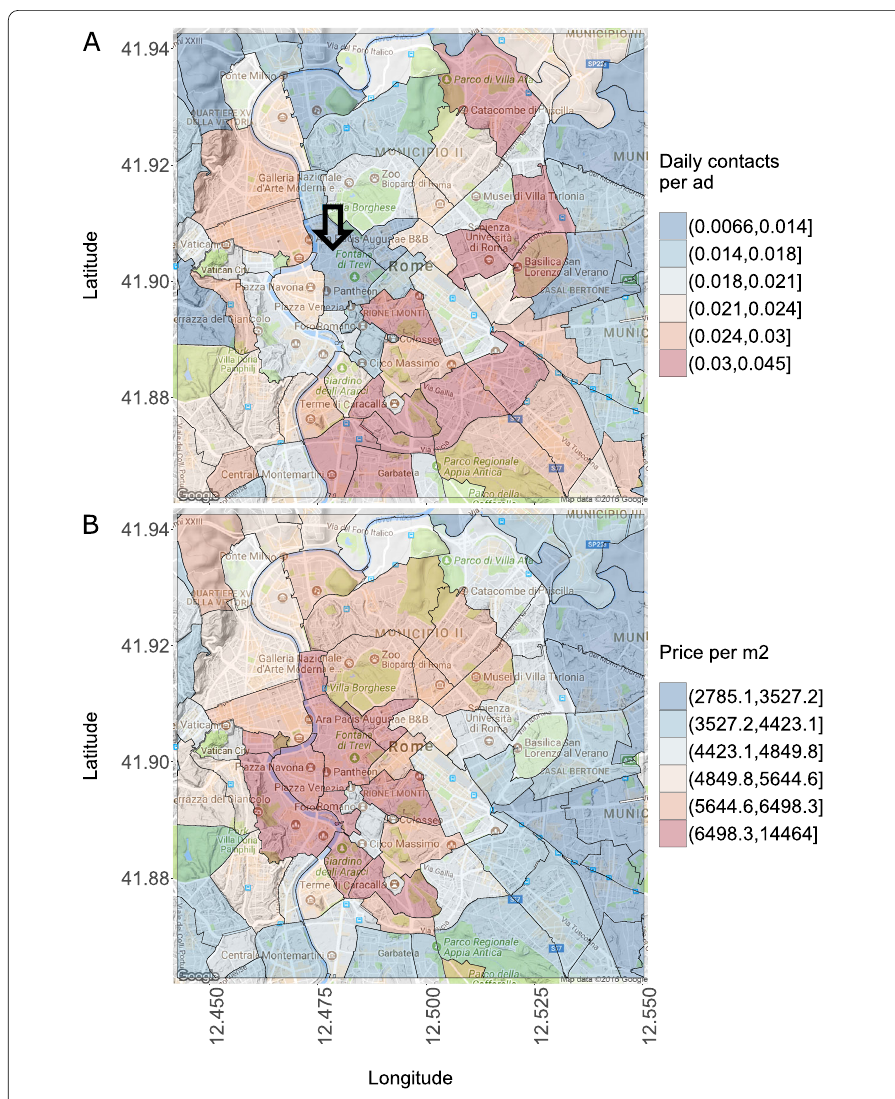
Figure 5 Contacts and price in Rome. Each polygon corresponds to an OMI microzone. ( A ) Daily contacts per ad, grouped in sixtiles. The arrow indicates one of the most touristic neighborhoods of Rome, which is however in the lowest sixtile of the contact distribution. ( B ) Price per m2, grouped in sixtiles. Prices are highest in the center, but higher in the North West than in the South East